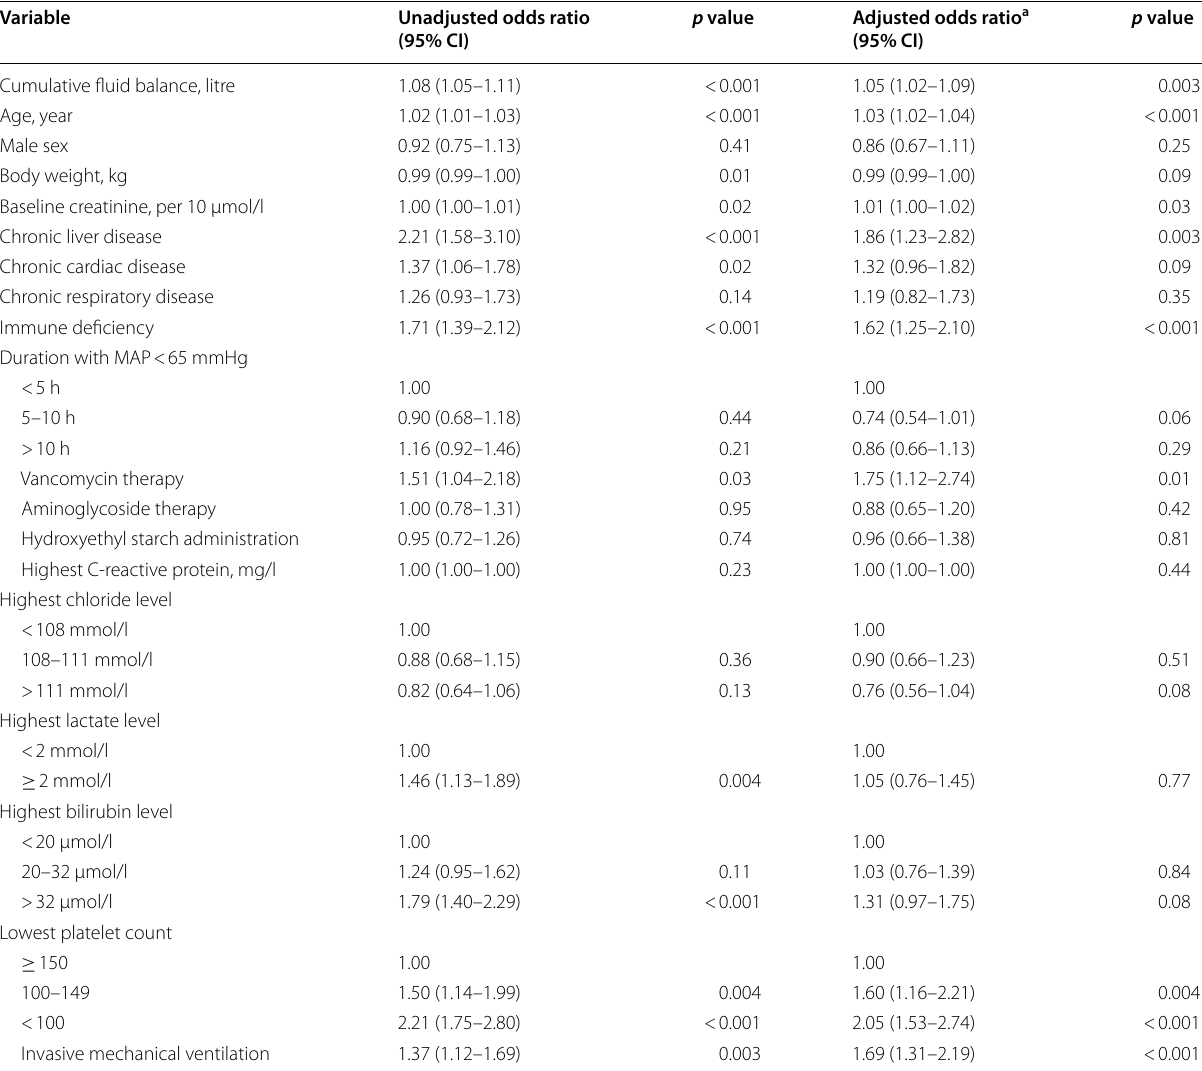
Table 5 Multivariable logistic regression analysis showing the association with major adverse kidney events within 30